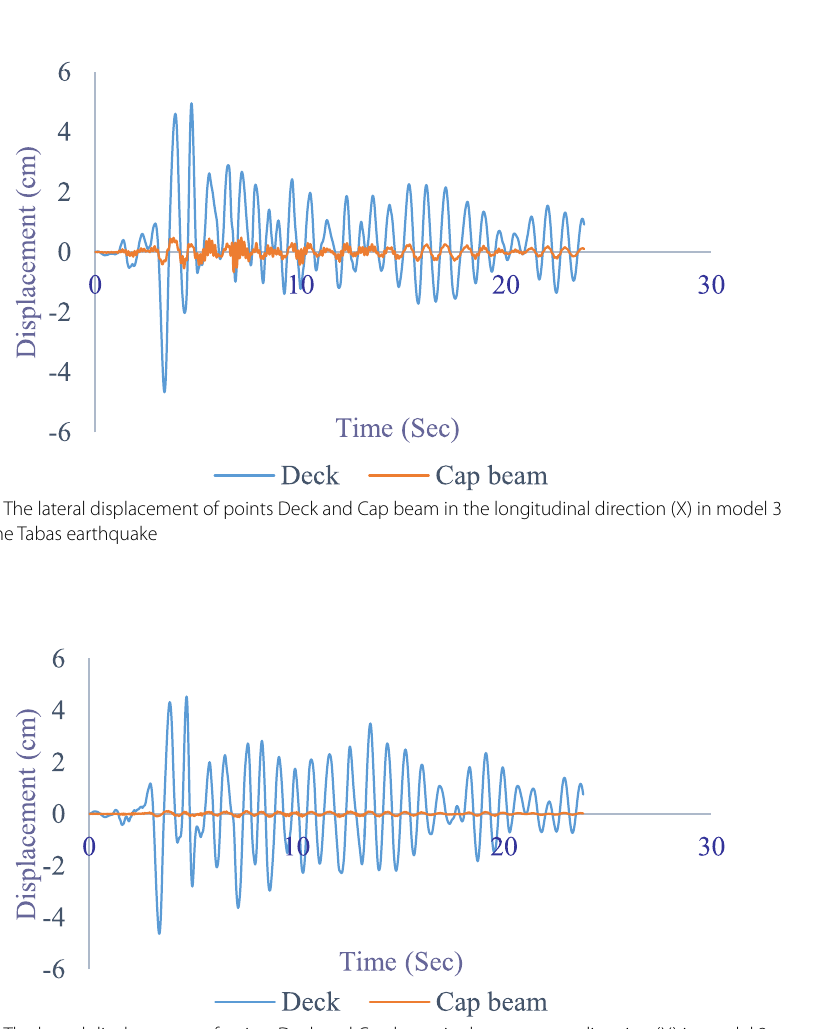
Fig. 18 The lateral displacement of points Deck and Cap beam in the transverse direction (Y) in model 3 under the Tabas